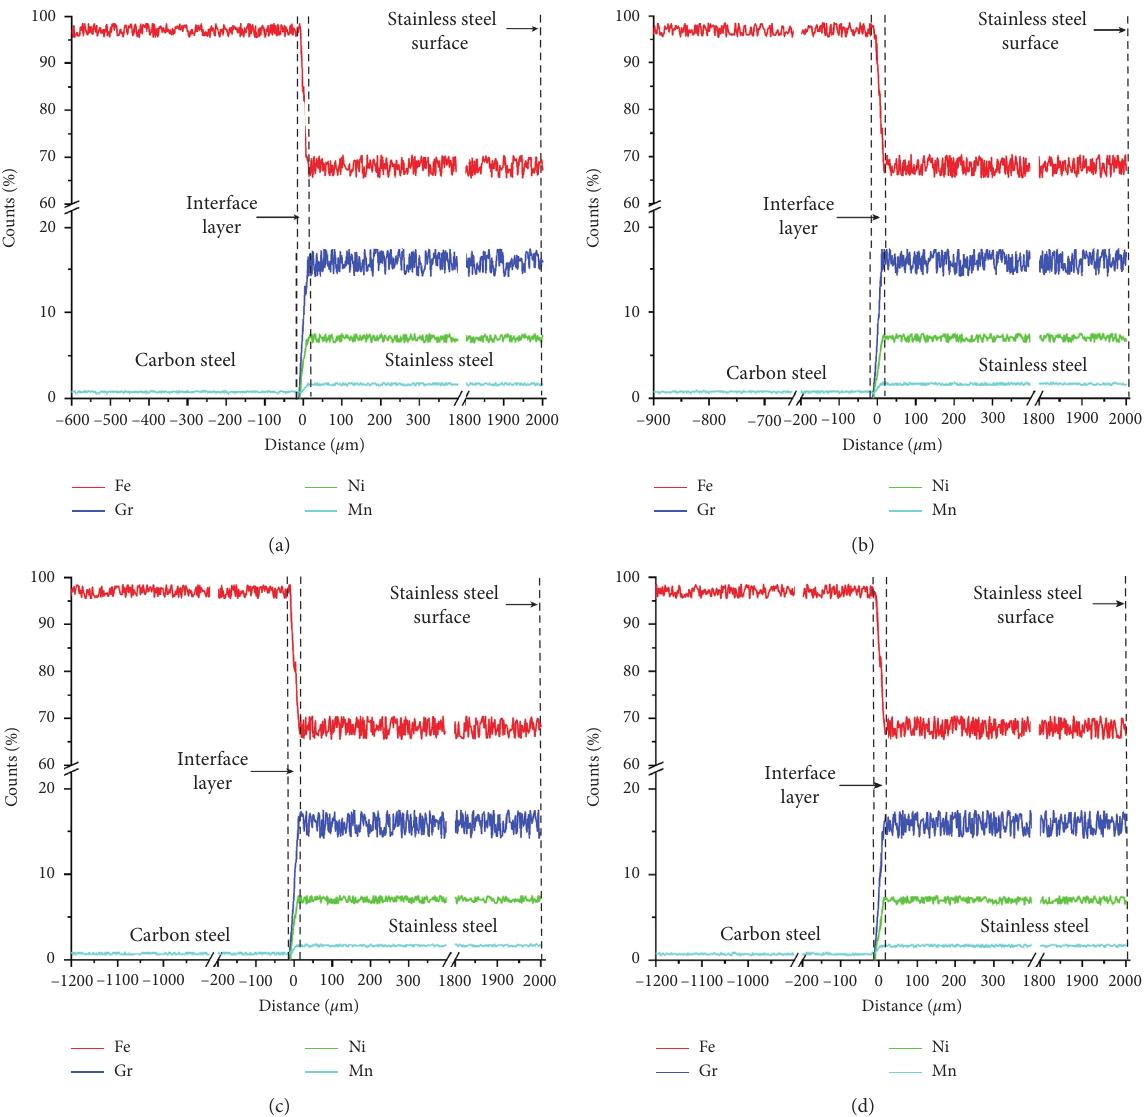
Figure 10: The element distribution of Fe, Cr, Ni, and Mn in the thickness direction of the bimetal plate at 700 ° C with different annealing times: (a) 2h, (b) 4h, (c) 6h, and (d) 8